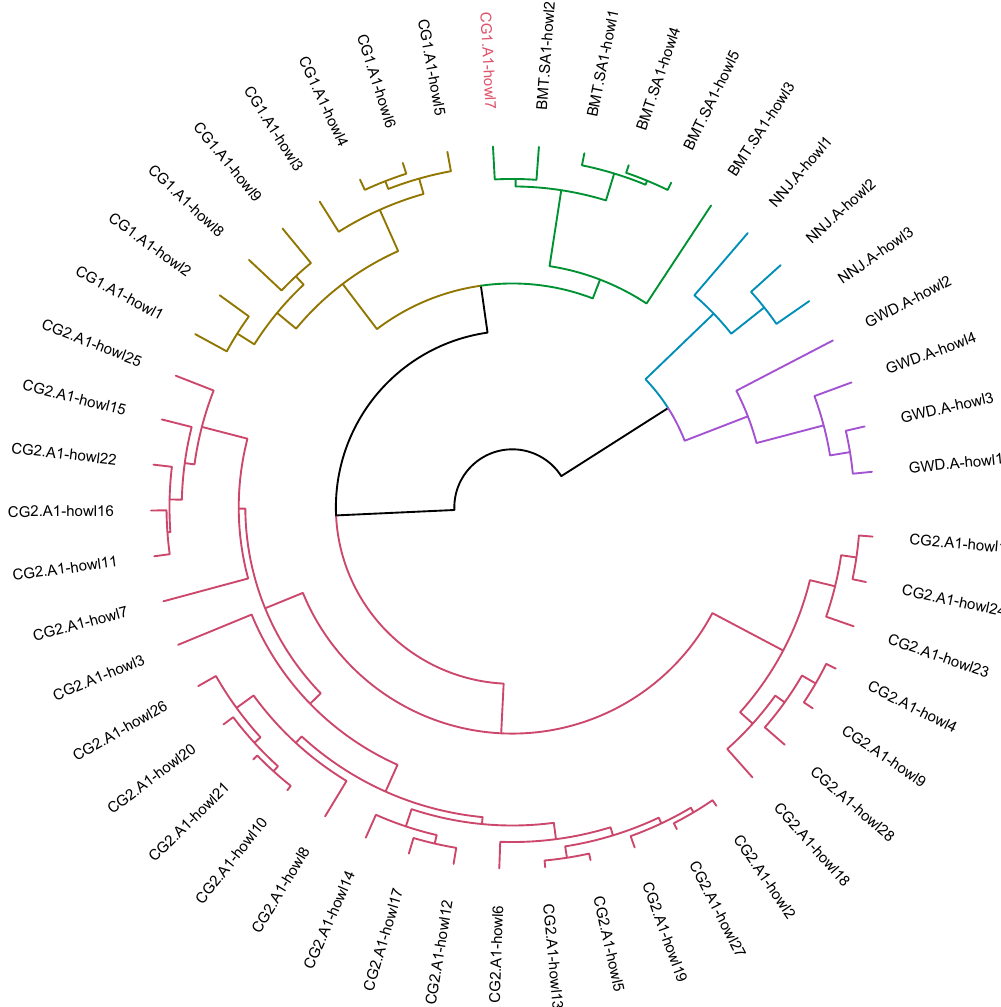
Figure 6. Hierarchical Clustering of 49 howls from five individuals. These 49 howls were used in training the data. 48 howls were identified correctly with the accuracy of 97.9%. The wrongly identified howl is marked in